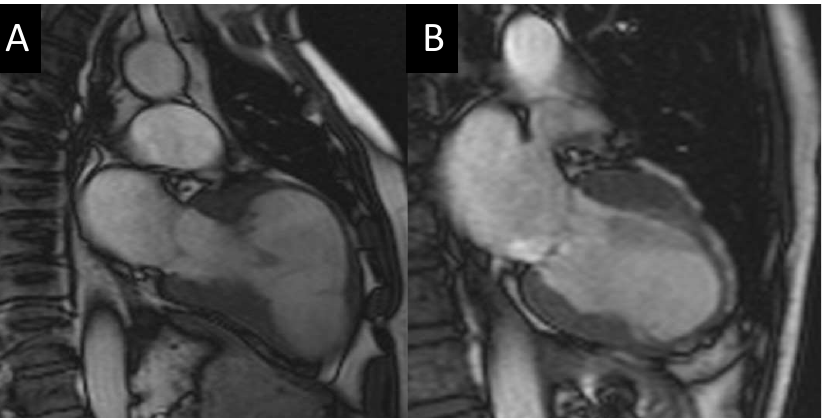
Figure 4. Cardiac MR imaging of a 72-year-old man with an occluded left anterior descendent coronary artery treated with a by-pass and surgical ventricle restoration. Two-chamber cine true fast imaging with steady-state free precession sequence in the end-systolic phase before ( A ) and six months after surgery ( B ).